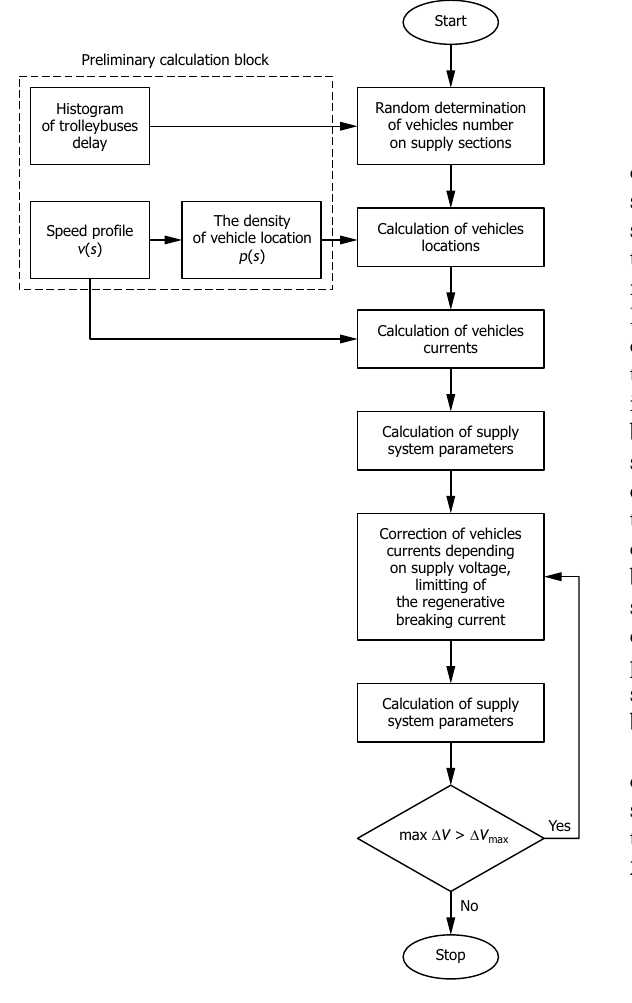
Fig. 9. General scheme of the traction power supply system simulation model using the Monte Carlo method Table 2. A comparison of the three options for trolleybus power